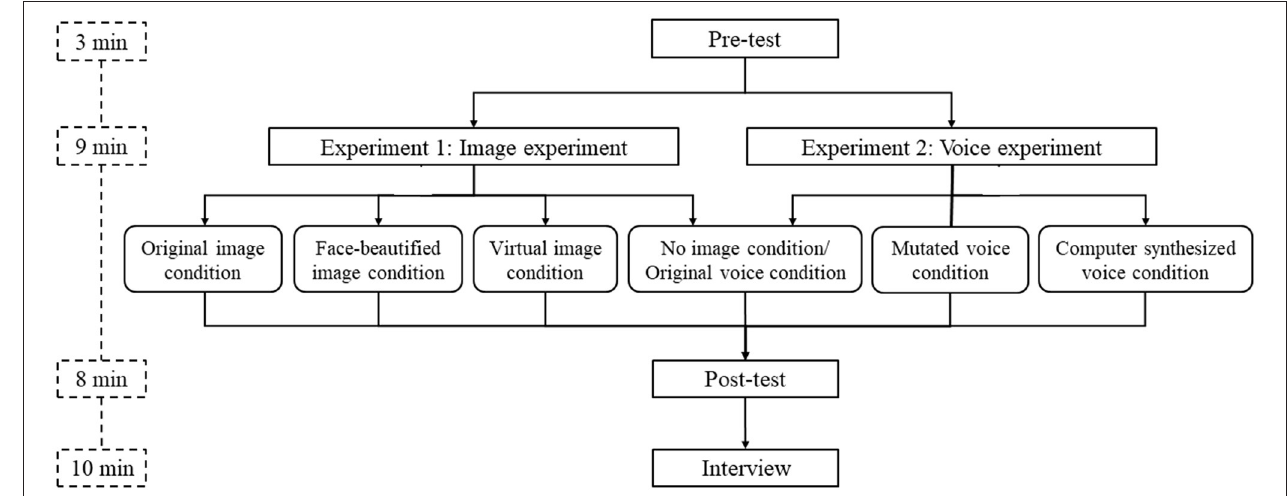
FIGURE 2 | Diagram of experiment